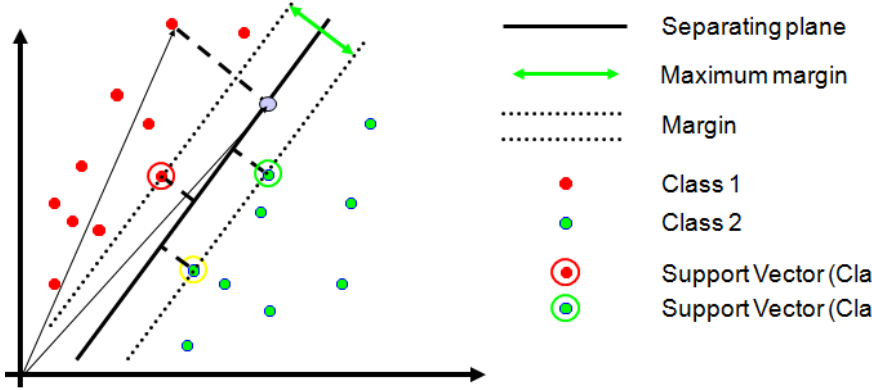
Figure 9. Support vector machine (SVM) classification system.